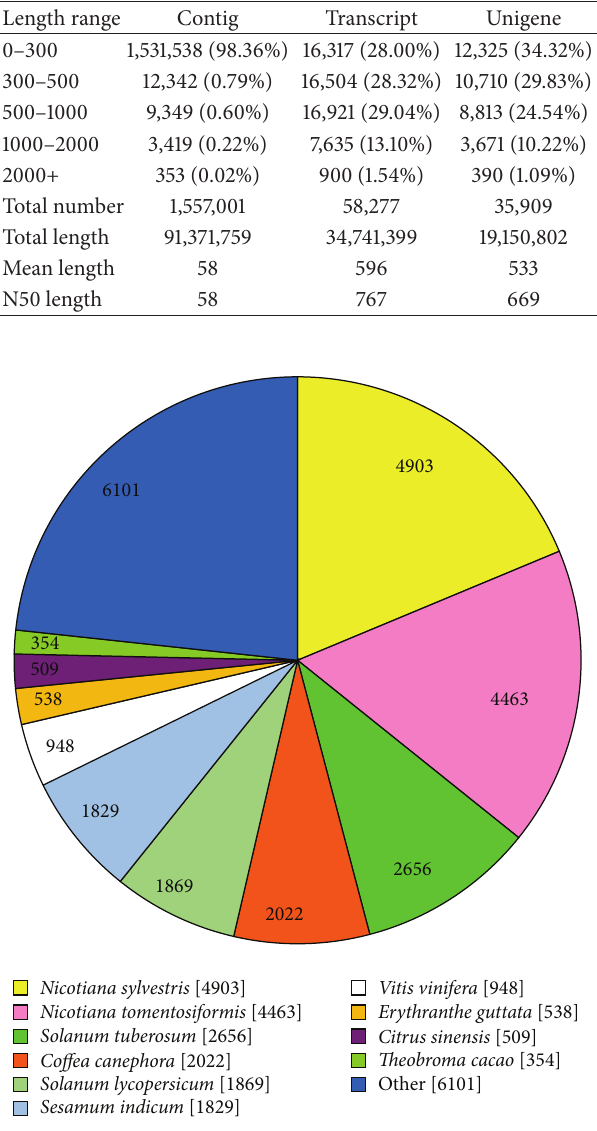
Figure 2: Species distribution of thetop BlastX hits foreach unigene in the Nr database.